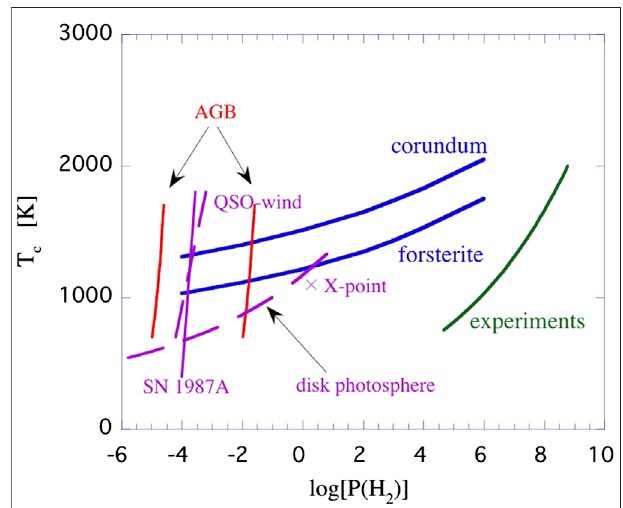
FIGURE 6 | Theoretical, experimental and astronomical studies on the condensation of silicates and oxides in a gas with Solar elemental composition. Total hydrogen pressures are in dyn cm − 2 . The solid curves labelledcorundum andforsteriterepresenttheresultsofthermodynamic equilibrium calculations for the condensation temperature at a given pressure (Salpeter, 1977) (see also Figure 1 ). The results of laboratory studies on the critical pressure at which nucleation (of Si 2 O 3 ) was detected in a SiO gas at a given temperature is shown as the green line labeled experiments (Nuth & Donn, 1982). These critical SiO pressures have been converted into H 2 pressures using the Si elemental abundance. The two almost vertical red lines labelled AGB show the relation between pressure and temperature in the circumstellar winds of Asymptotic Giant Branch stars around the sonic point for two different mass loss rates (10 – 7 − 10 – 4 M ⊙ /yr). Because of freeze out, for these dust-driven winds, the bulk of the dust should condense close to the sonic point. The solid purple line indicates the estimated gas pressure and temperature at day 615 in SN 1987A when dust formation was clearly proceeding (Wooden et al., 1993). The top part refers to the gas temperature in the C-O zone cooled by gaseous CO (~1800 K), while the bottom part is appropriate for the observed dust temperature (400 K). The dashed purple linelabeled QSO refer to conditions expectedfor the quasar wind in PG212 + 059 where presumably newly condensed oxides have been detected in the mid-IR spectrum (Markwick-Kemper et al., 2007). Calculated temperatures and pressures in the photosphere of a passively heated disk at a distance of 0.1-1AUaroundaT-Tauristarareshownasadashed purpleline(Chiangand Godreich, 1999). For such an externally irradiated disk, temperatures in the interior are much less. Actively accreting disks will have much higher temperatures in their mid-planes (as well as in their photospheres). The X indicates the estimated conditions at the X-point in magnetocentrifugally driven fl ows from T-Tauri